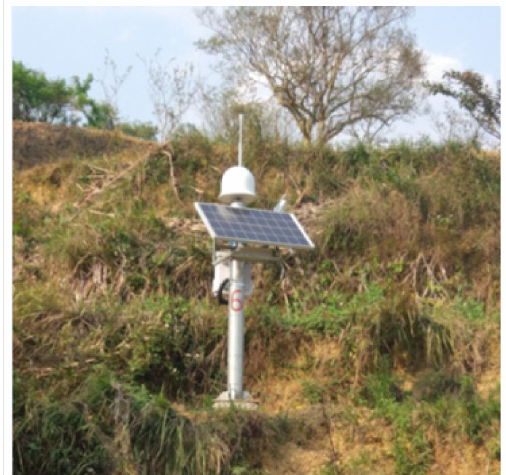
Figure 6. Experimental data collection site.